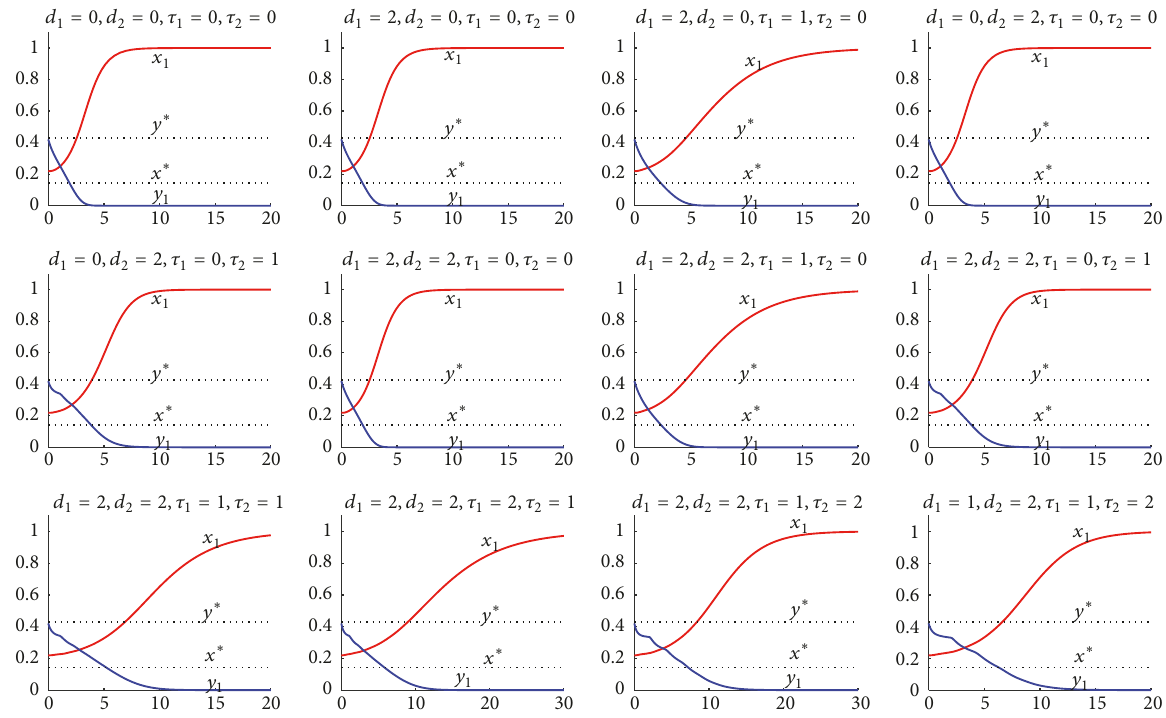
Figure 3: Numerical solutions of system (2). The symmetric coexistence equilibrium is unstable with parameters 𝑎 = 2 , 𝑏 = 4 , and 𝜌 = 2 . Initial condition is set as (𝑥 1 (0),𝑦 1 (0),𝑥 2 (0),𝑦 2 (0)) = (0.22, 0.42, 0.22, 0.42)